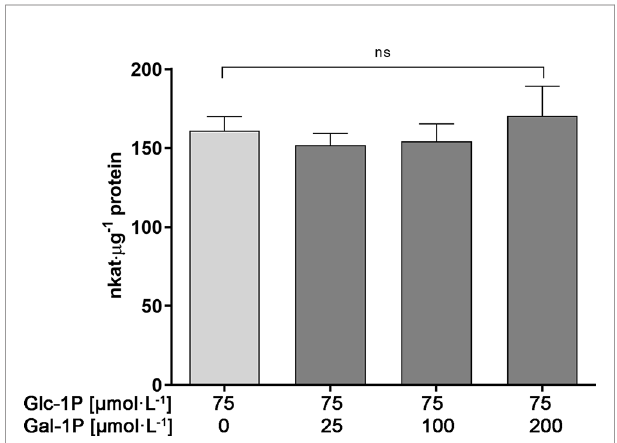
FIGURE 4 | Enzyme activity of PGM3 in the presence of various concentrations of Gal-1P. Even a three-fold surplus of Gal-1P over Glc-1P does not inhibit the PGM3 enzyme activity. Gal-1P concentrations were chosen on the basis of metabolite measurements for Gal-1P found in plants under Gal-feeding conditions. Glc-1P concentration were chosen based on published metabolite data (Arrivault et al., 2009; Szecowka et al., 2013). Mean values of six independently performed measurements are depicted (± SD). Data analysis was performed using one-way Anova and Dunnett ’ s multiple comparisons test; ns, non signi fi